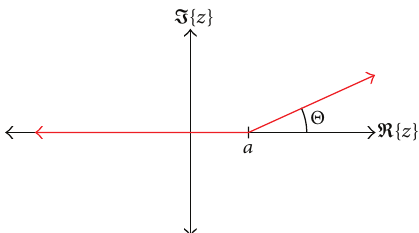
Figure 1: An example contour in the complex plane that serves as a “complexified” spatial axis in a model of an open quantum system in which a non-Hermitian Hamiltonian (1) acts in the space of functions defined along the contour. Both smooth and piecewise linear contours are admissible for our purposes. In this example, the domain of the Hamiltonian would be specified by requiring that 𝑓(𝑎 − ) = 𝑓(𝑎 + ) and that an analogue of Cauchy-Riemann condition, 𝑓 󸀠 (𝑎 − ) = 𝑒 −𝑖Θ 𝑓 󸀠 (𝑎 + ) , is satisfied for derivatives along the contour for all 𝑓 ∈ 𝐷(𝐻) . We also assume that the potential 𝑉(𝑥) has a compact supportwitha“radius”smallerthan 𝑎 ,sothatnonanalyticpotentials can be